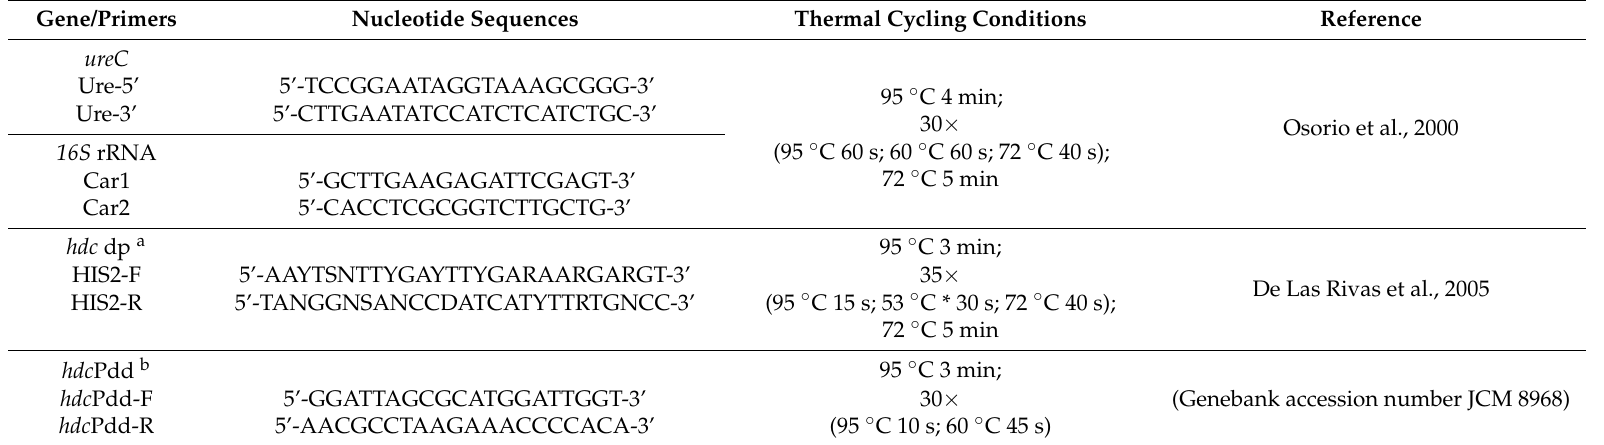
Table 1. Primers and PCR protocols used for the identification of P. damselae subsp. damselae and its histidine decarboxylase